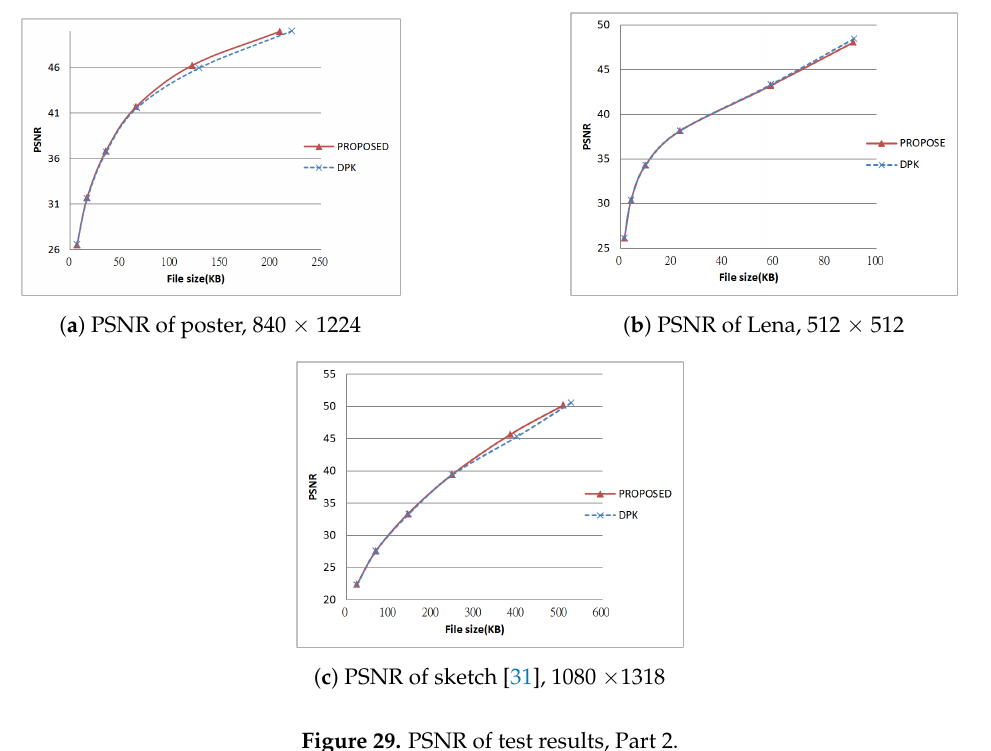
Figure 29. PSNR of test results, Part 2.